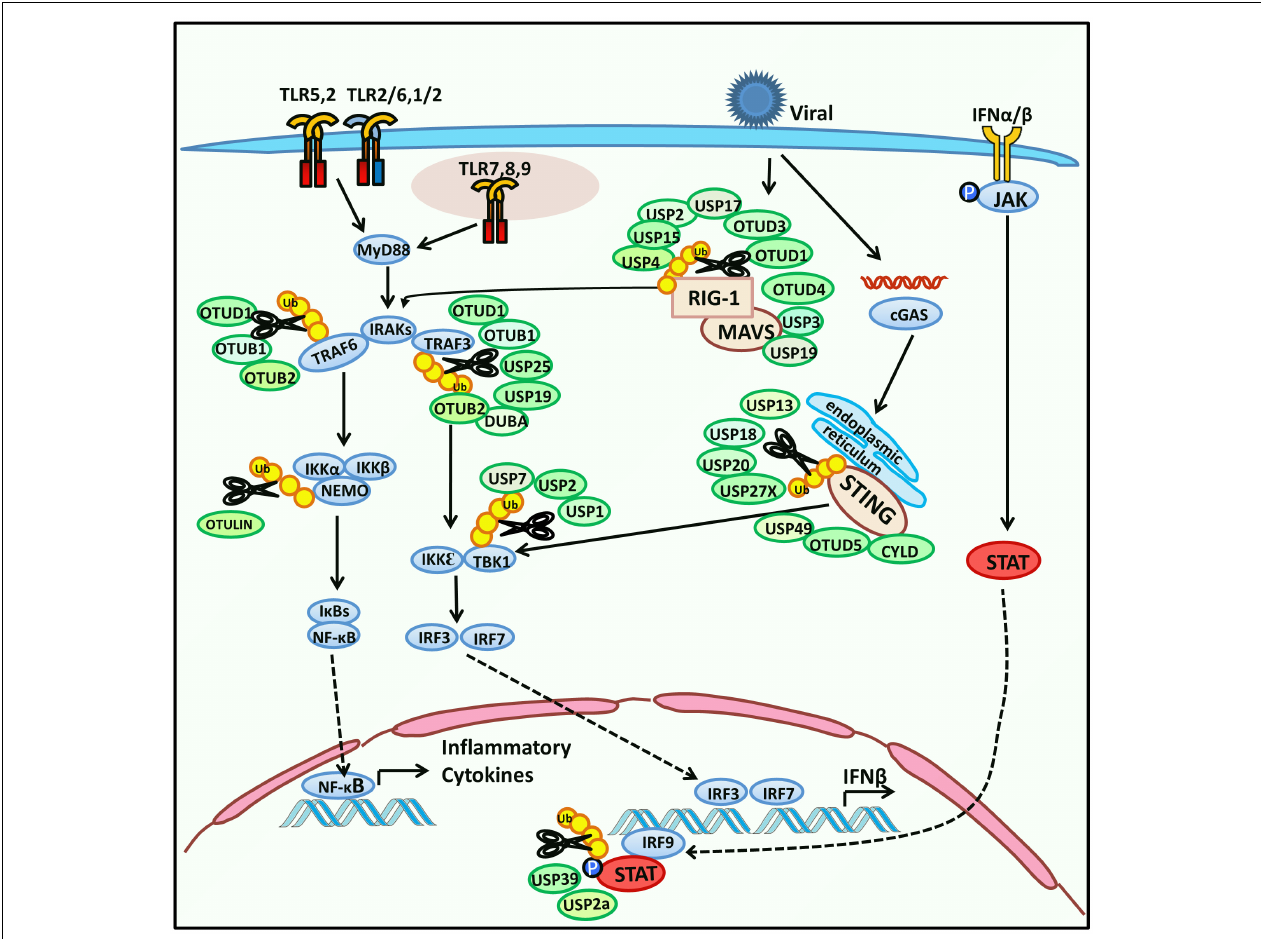
FIGURE 1 | Regulation of host-encoded DUBs in innate immune response. Toll-like receptors (TLRs) are a type of pattern-recognition receptors (PRRs) that recognize pathogen-associated molecular patterns (PAMPs) and subsequently change their conformation to initiate downstream signaling. TLRs are located on the cell membrane, phagosome membrane, endosome, and endoplasmic reticulum (TLRs on endosomes and endoplasmic reticulum are not shown). TLRs can activate the expression of NF- κ B or IRF3 and subsequently induce the expression of inflammatory cytokines or IFN- β in the nucleus. Activated TLRs recruit adaptor proteins, including TIRAP, MyD88, TRAM, and TRIF. First, the adaptors interact with IRAKs and TRAF6 and then activate NF- κ B through the TAK1-IKK-I κ B axis. Second, the adaptors mediate the expression of IRF3 via TRIF-TRAF3-TBK1 signaling. In addition, another PRR, RIG-I, which belongs to the RIG-I-like receptors (RLRs) family, is responsible for sensing RNA of pathogens. It interacts with MAVS, which further induces both NF- κ B and IRF3. Stimulator of interferon genes (STING), located on the endoplasmic reticulum senses cytoplasmic DNA and regulates IFN signaling by activating TBK1 and IRF3. IFN- β induces the phosphorylation of JAK and expression of interferon-stimulated genes (ISGs) by activating the downstream JAK-STAT pathway. Host-encoded DUBs interact with the above signaling molecules to modulate the innate immune response. Their deubiquitinating function and substrates are shown in the